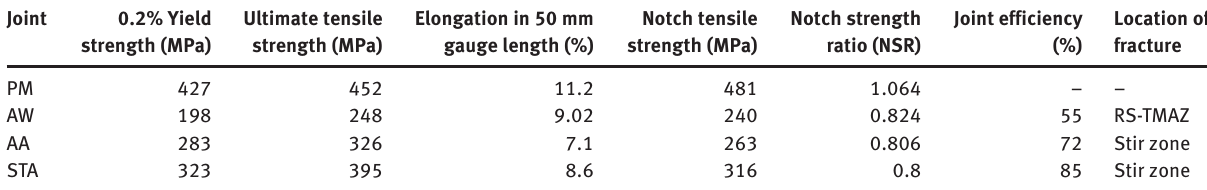
Table 2: Transverse tensile properties of parent metal and FSW